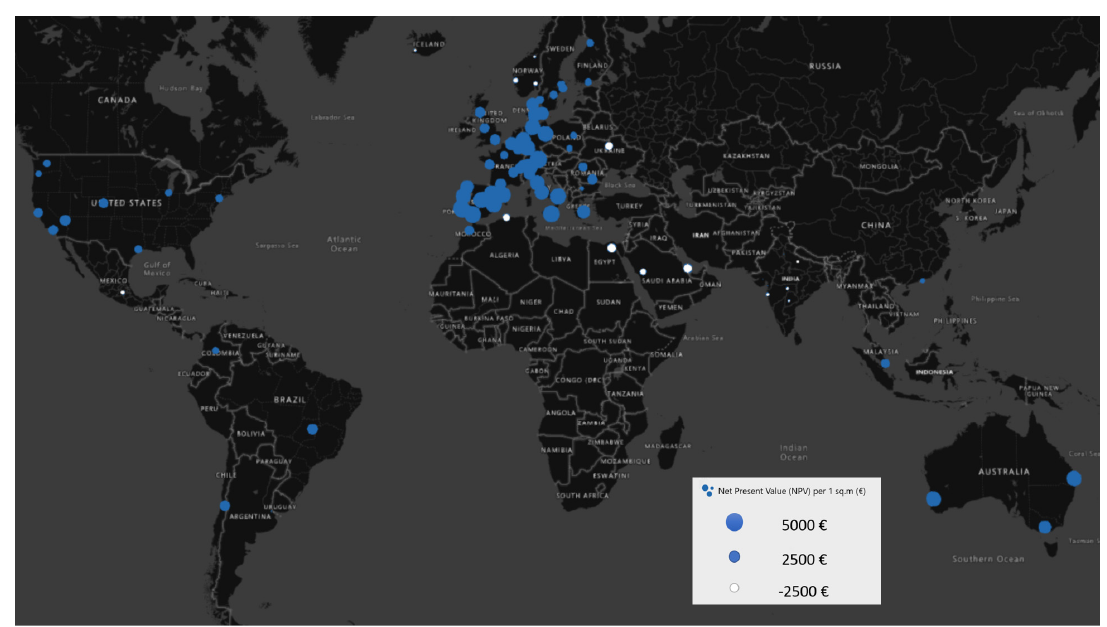
Figure 19. Net present value (NPV) potential per unit collector area for financing model 1.